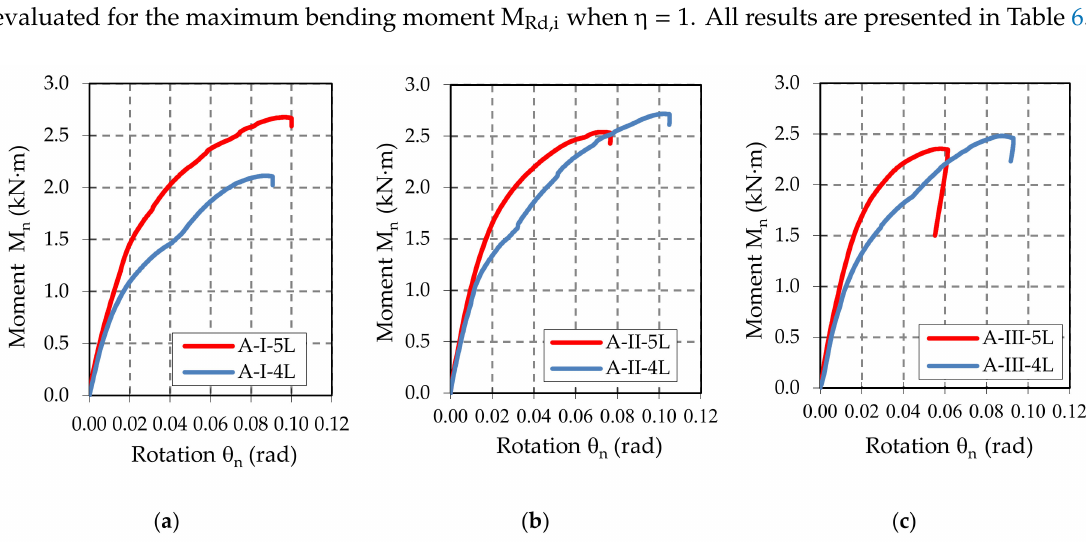
Figure 9. Comparison of the moment-rotation curves recorded for: ( a ) A-I-4L and A-I-5L assemblies,